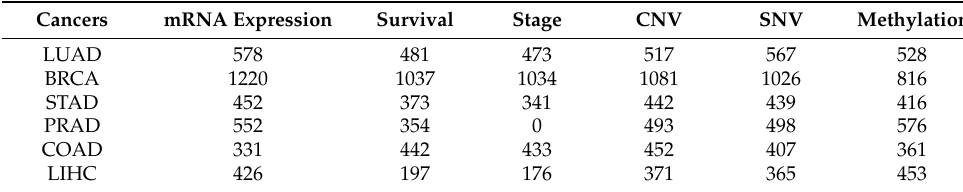
CNV: copy number variation, SNV: single nucleotide